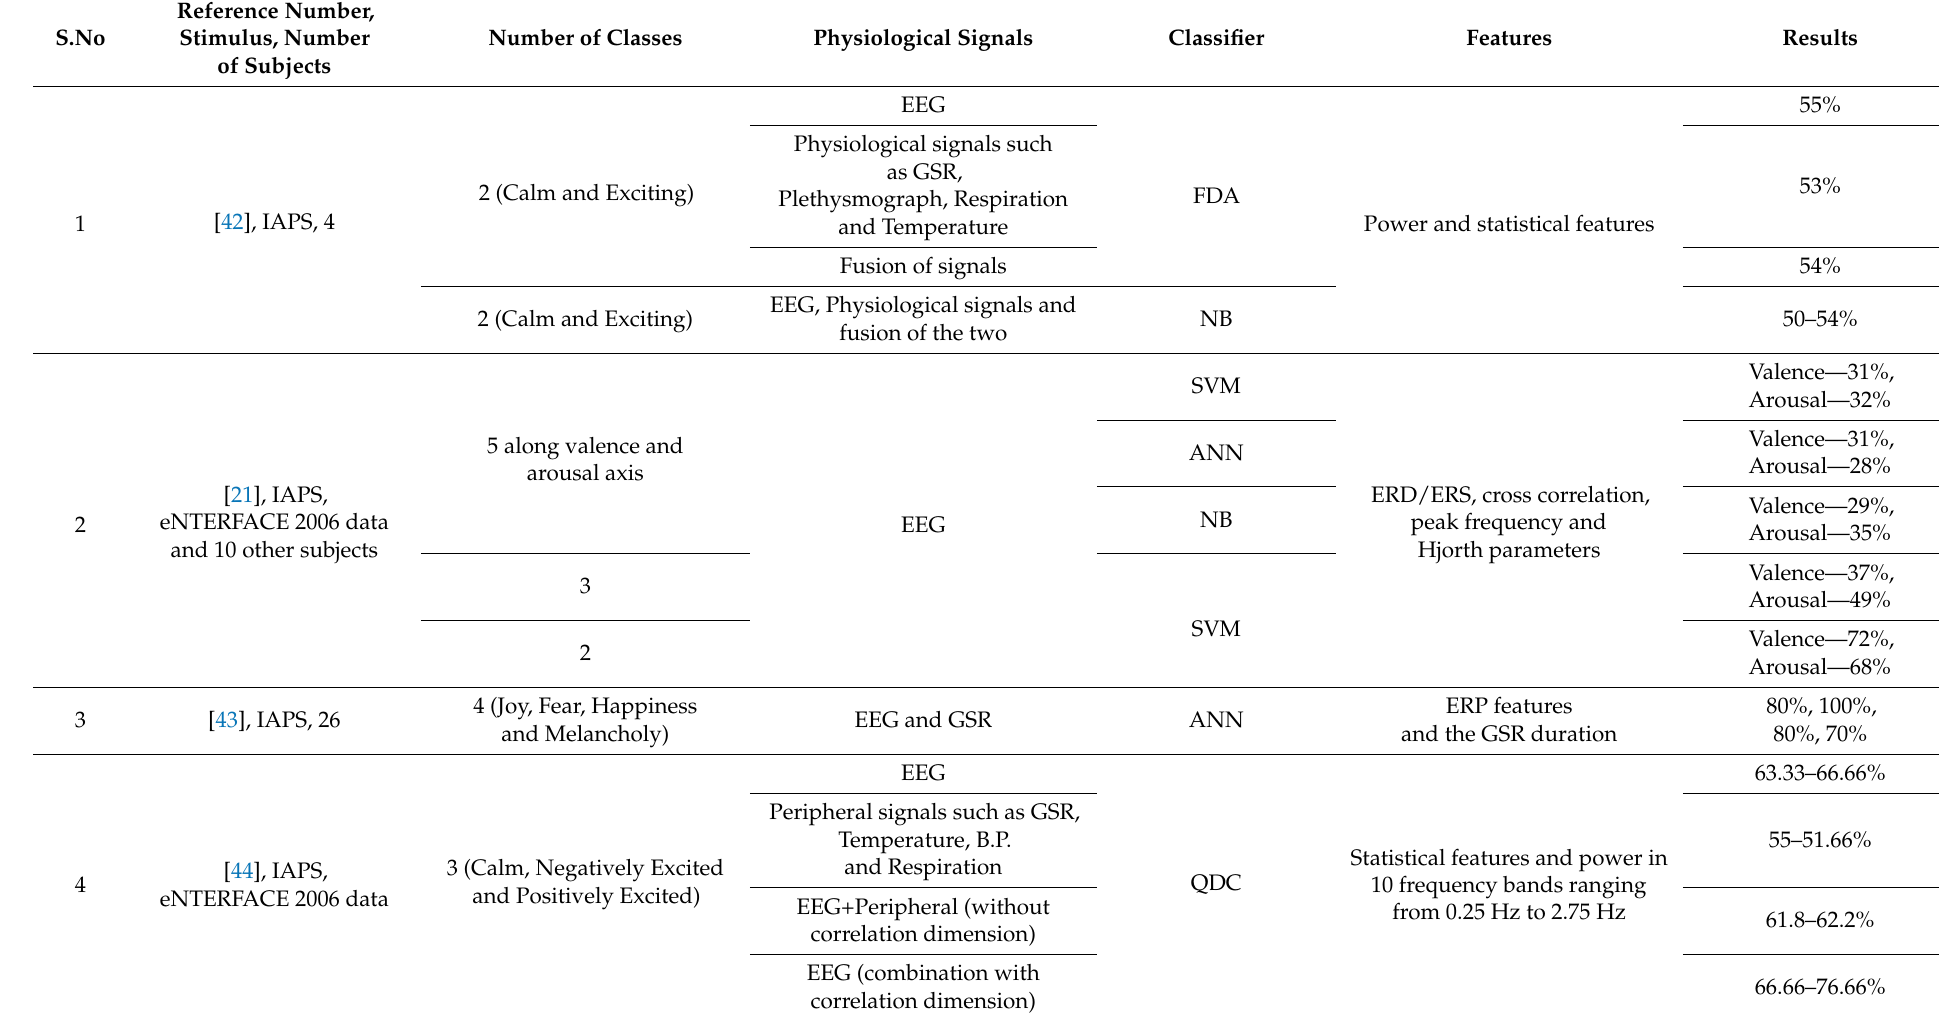
Table 1. A review of studies on emotion